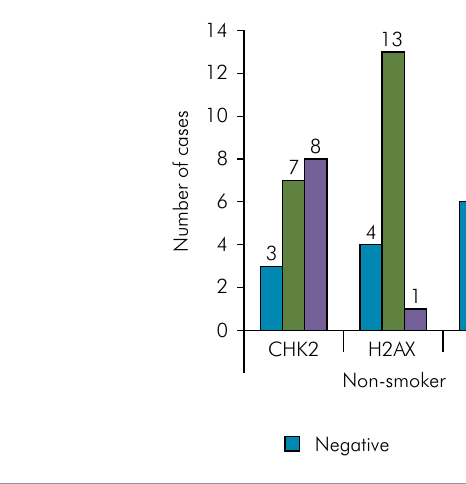
Figure 1. Overall distribution of immunostaining in smokers and non-smokers.